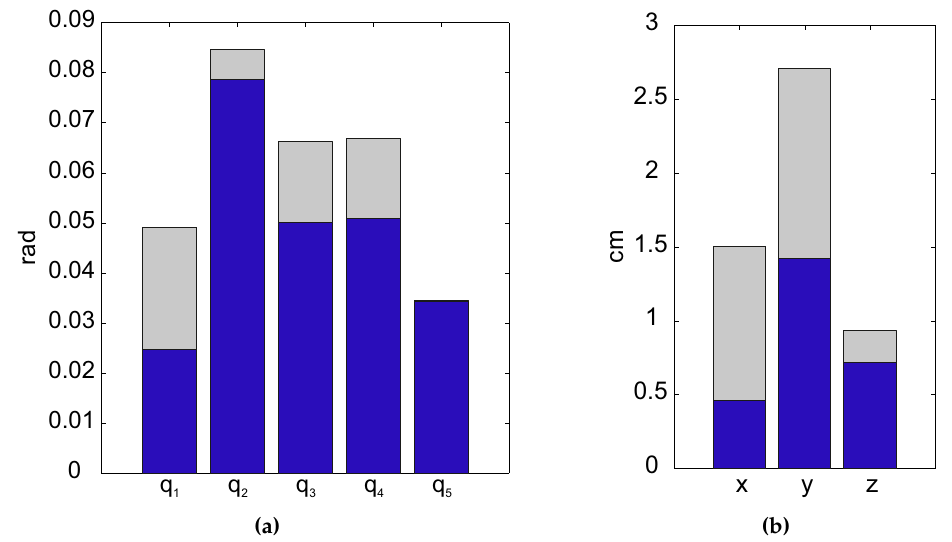
Figure 5. Error committed in the reconstruction algorithm. ( a ) Mean RMSE (blue bar) of the joints committed by the subjects and standard deviation (gray bar); ( b ) Mean RMSE (blue bar) of the shoulder position committed by the subjects and the standard deviation (gray bar): x, left/right movements; y, forward/backward movements; z, up/down movements.